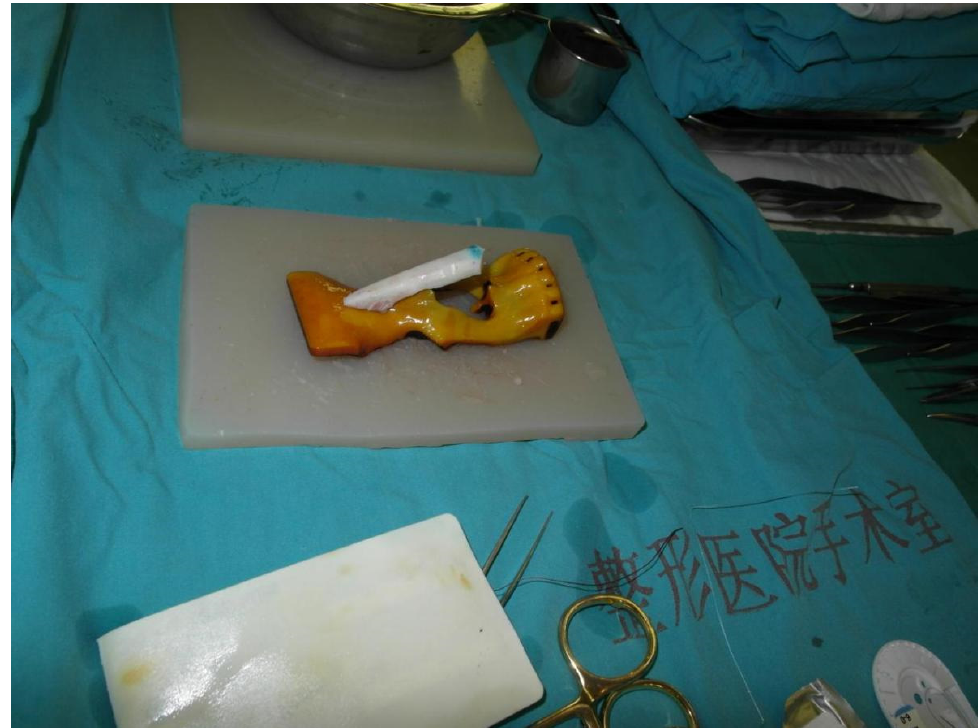
Figure 2. After the 3D printing model was sterilized, we put the carved ribs along with it during the operation.